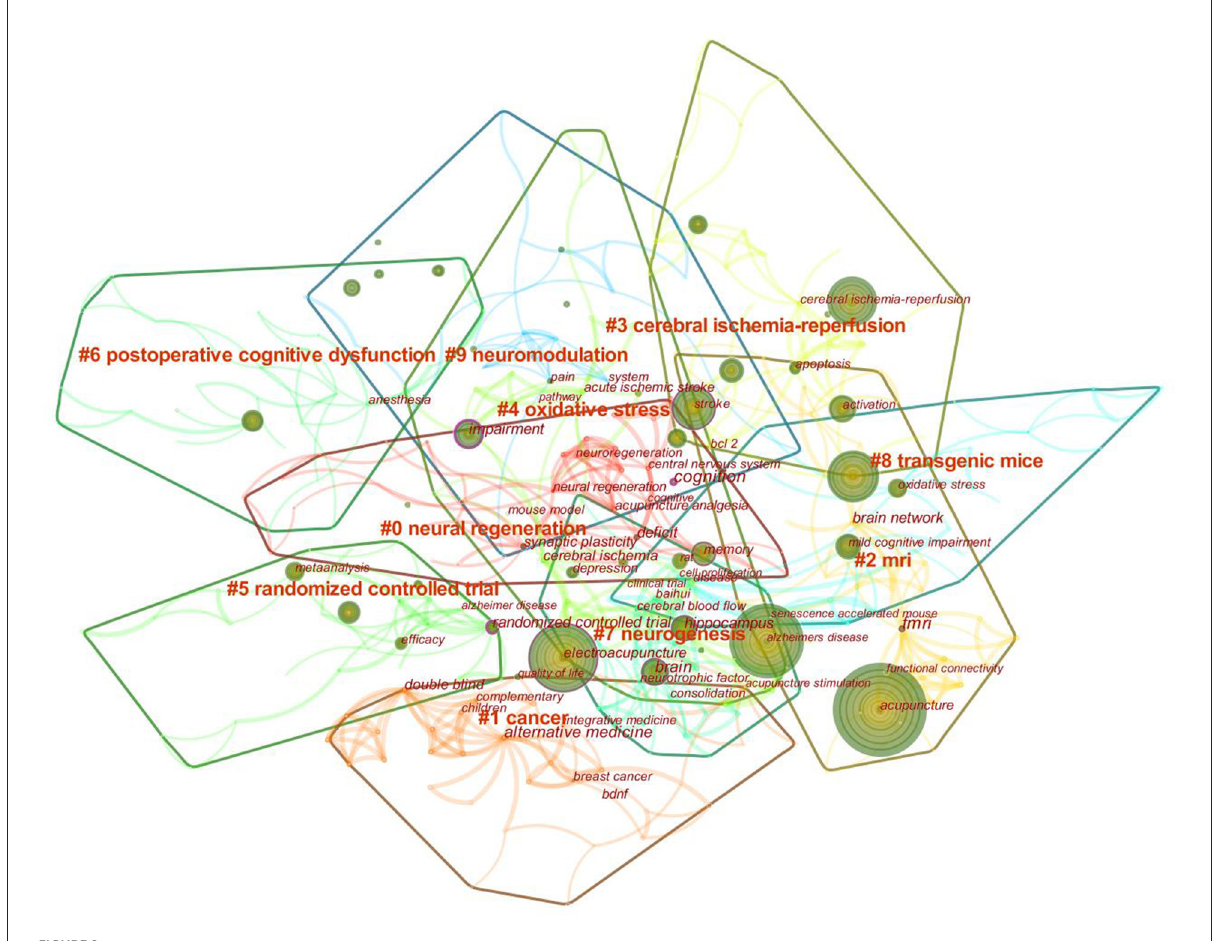
FIGURE9 Clustering of